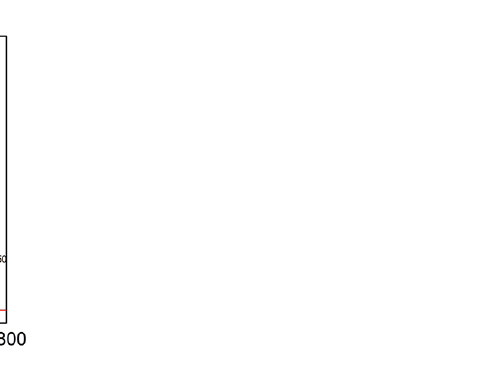
Figure 2. The magnetization of Co measured during heating and cooling process in 0.52 T magnetic field and field gradient of 7.8 T/m. Inset is the enlarged area showing the magnetization variations around the nucleation